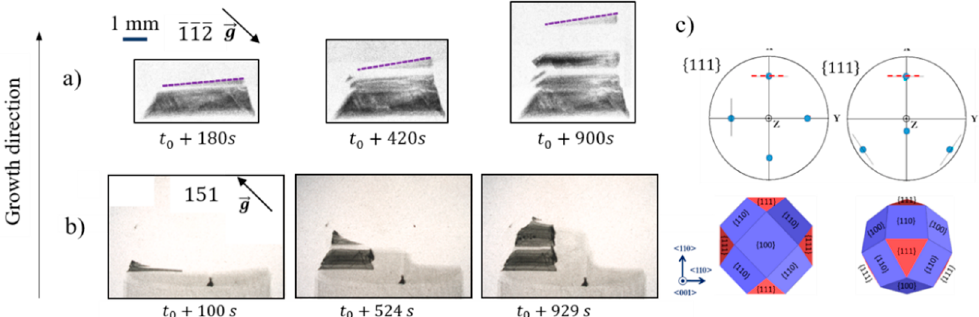
Figure 7. Image sequence of di ff raction spot images—topographs corresponding to twinning zones. ( a ) twinning zone corresponding to the right side of sample Figure 5d. The purple dotted line corresponds to the solid–liquid interface. ( b ) Twinning zone corresponding to the left side of sample Figures 5c and 6b. ( c ) Stereographic projections of the { 111 } planes of the seed (left) and the first twin (right) with both horizontal projections for the experiment in ( b ) and the corresponding 3D representation of the plane arrangements (below).